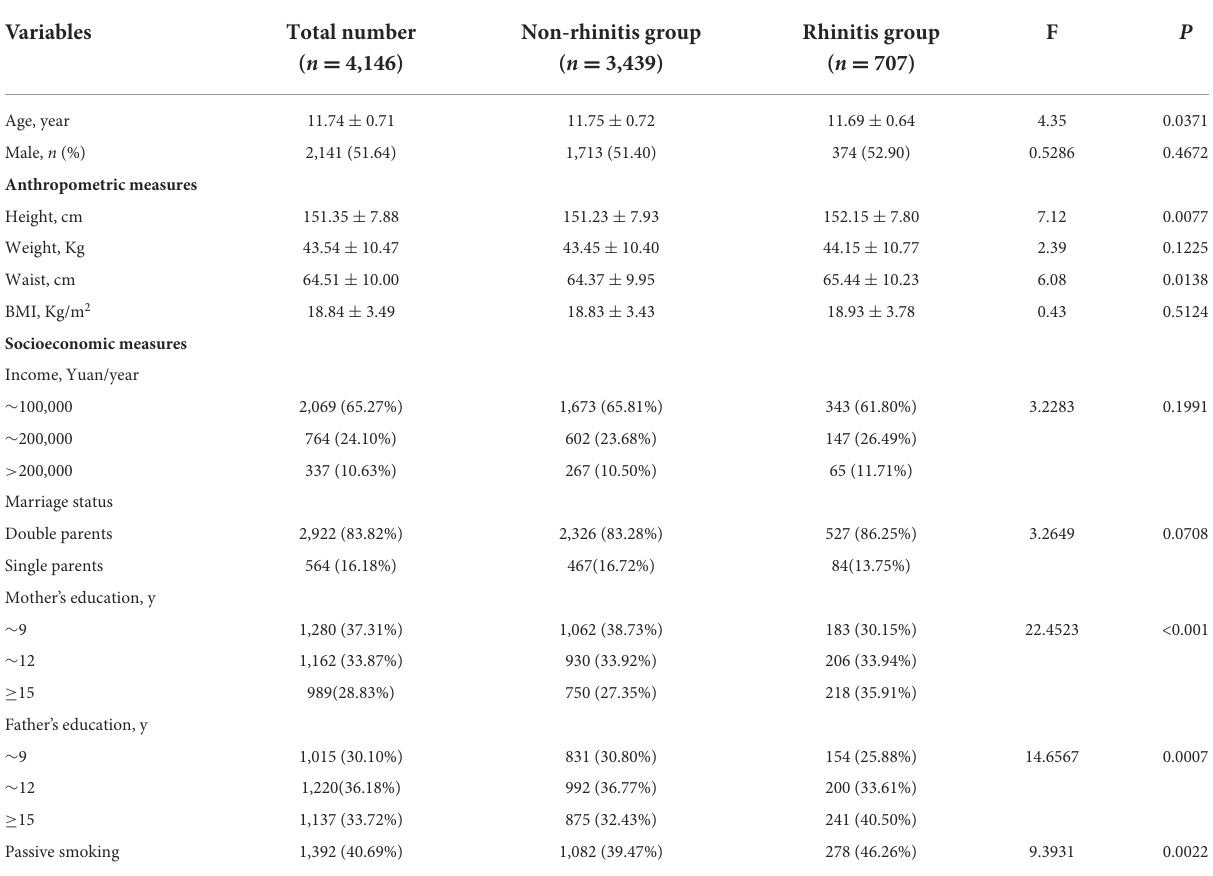
TABLE 1 Characteristics of study